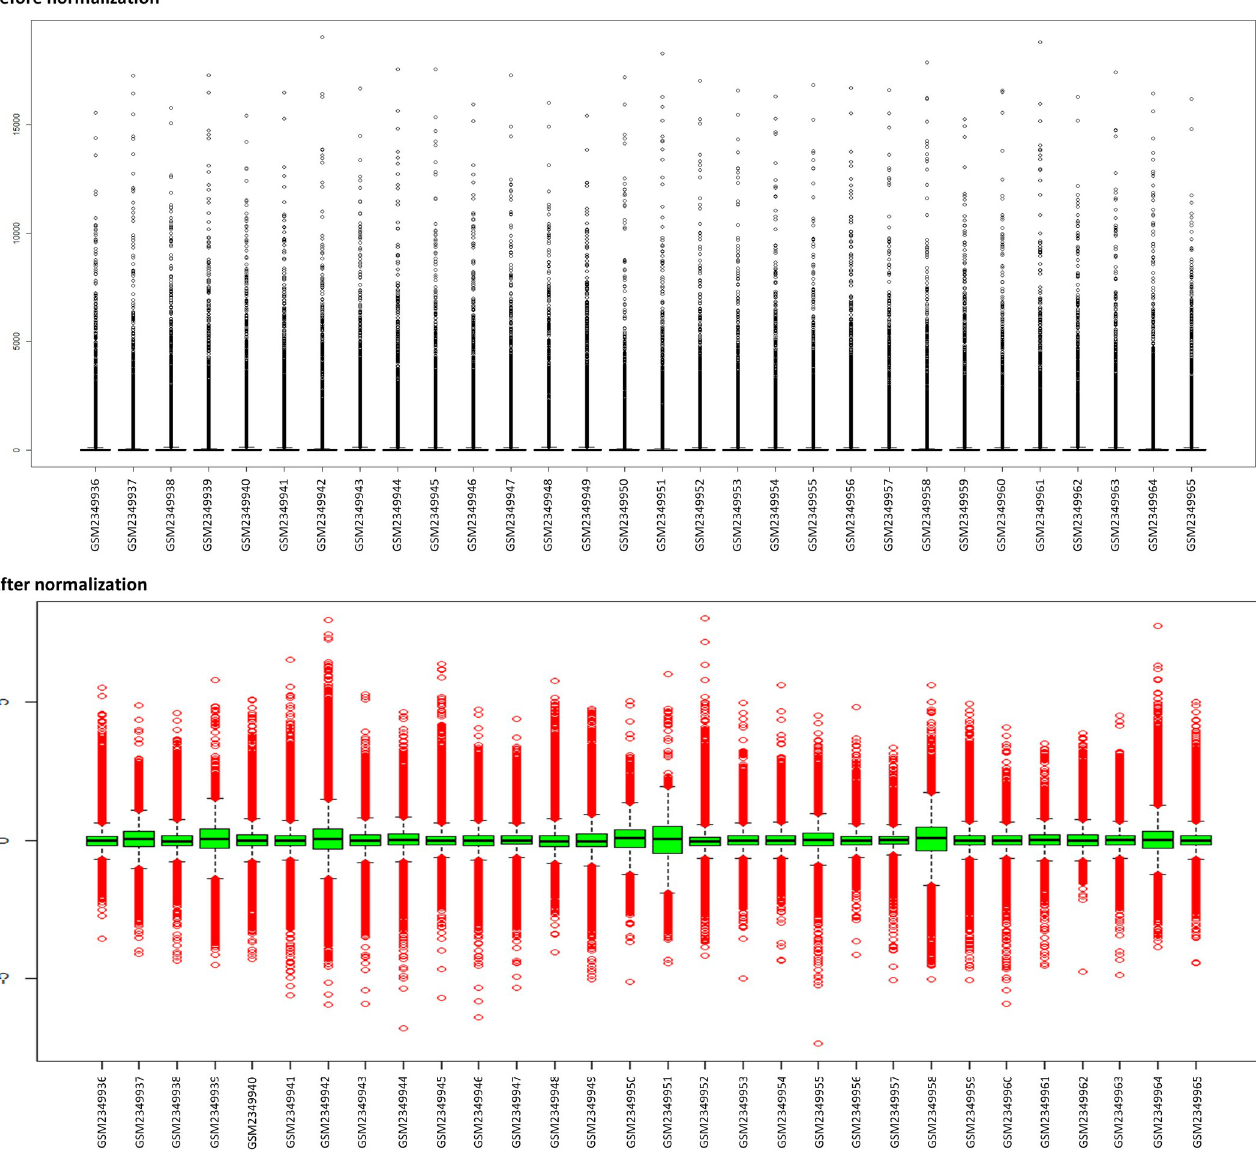
PLOS ONE | https://doi.org/10.1371/journal.pone.0228400 February 6,